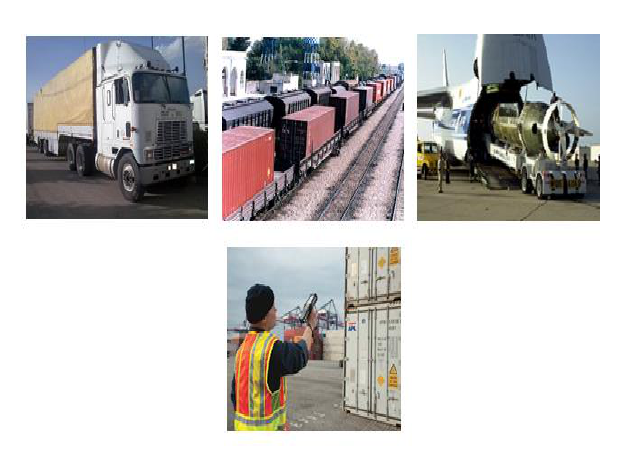
Figure 2. Determining the mean of transportation by the main distribution center and reading the information of truck tags from distance by